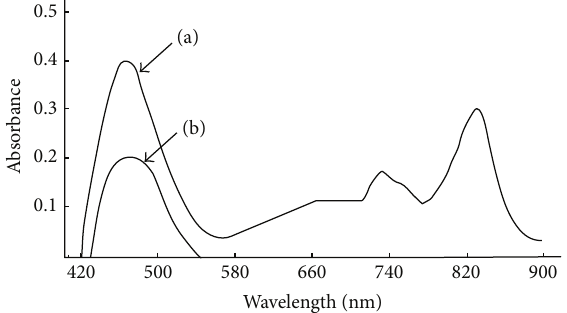
Figure 2: Absorption spectra for the complexes of 0.5 mL of 1 × 10 −3 M TCNQ and (a) 1 𝜇 g/mL ethylamine and (b) 2 𝜇 g/mL 1,2- diaminopropane versus